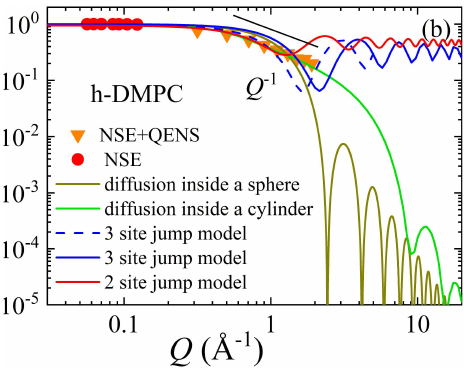
Fig. 6 . Elastic incoherent structure factor for h-DMPC lipids obtained from NSE (SNS) and BASIS (SNS) studies. The data are modeled with motions within a sphere, a cylinder, and compared with three and two site jump models. Reprinted with permission from [18]. Copyright 2020 The Royal Society of Chemistry.